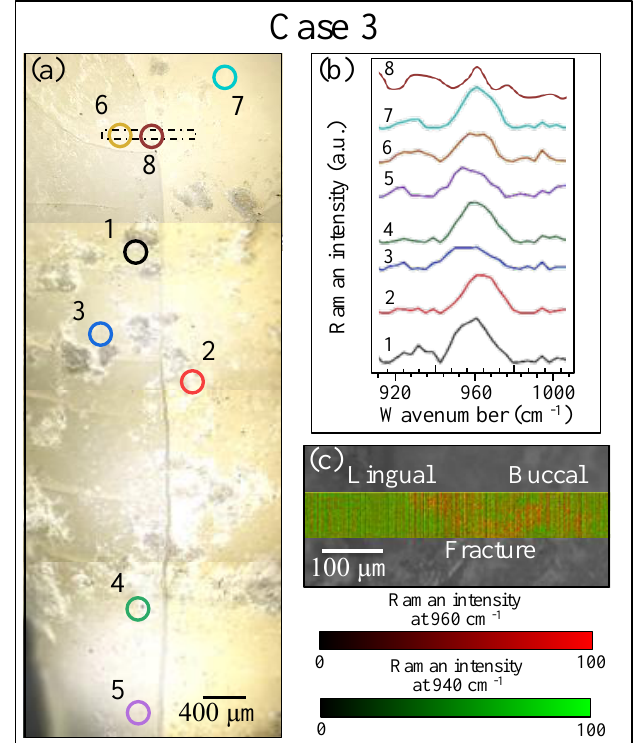
Figure 10. Raman analysis of the tooth sample in Case 3: ( a ) optical image (100 × lens) showing locations (1~8) selected for point analysis, ( b ) recorded Raman spectra (10 × lens) at the selected locations in the spectral region around 960 cm − 1 , and ( c ) Raman map corresponding to the area indicated by the rectangular inset in ( a ).